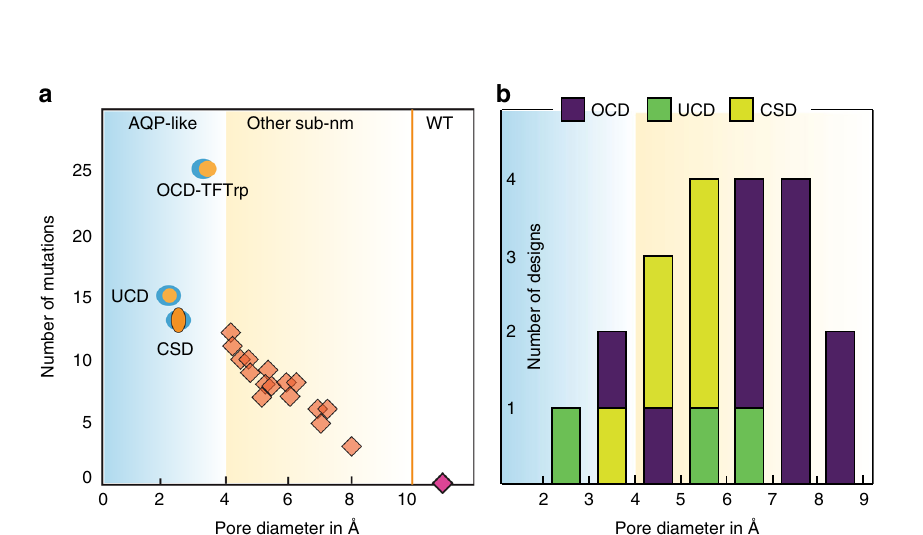
Fig. 3 Twenty OmpF mutants spanning the entire sub-nm range were designed. a Plot of the number of mutations vs. pore diameter for 20 mutants (including three mutants that were validated experimentally before MD simulations). The general trend indicates that the smaller the desired pore, the greater the number of mutations required. b Plot of the number of designs for each pore size and type classi fi cation